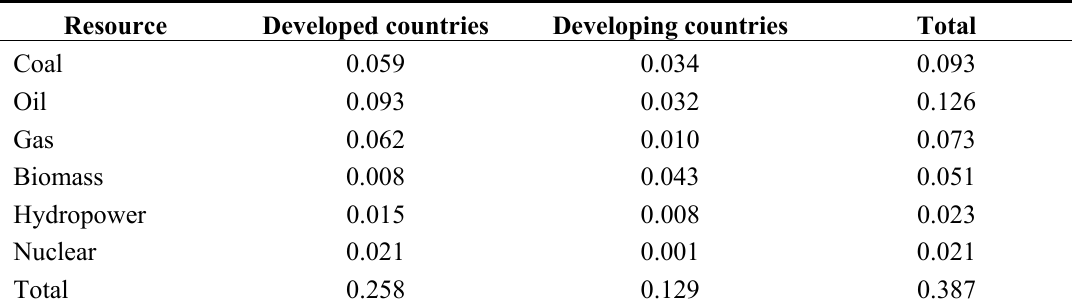
Table 1. World energy consumption in 1990 (in